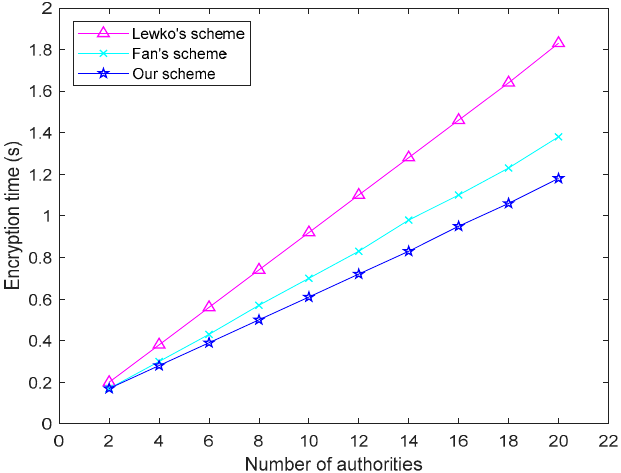
Figure 5. Relation between consumer decryption and encryption time and number of authorities.